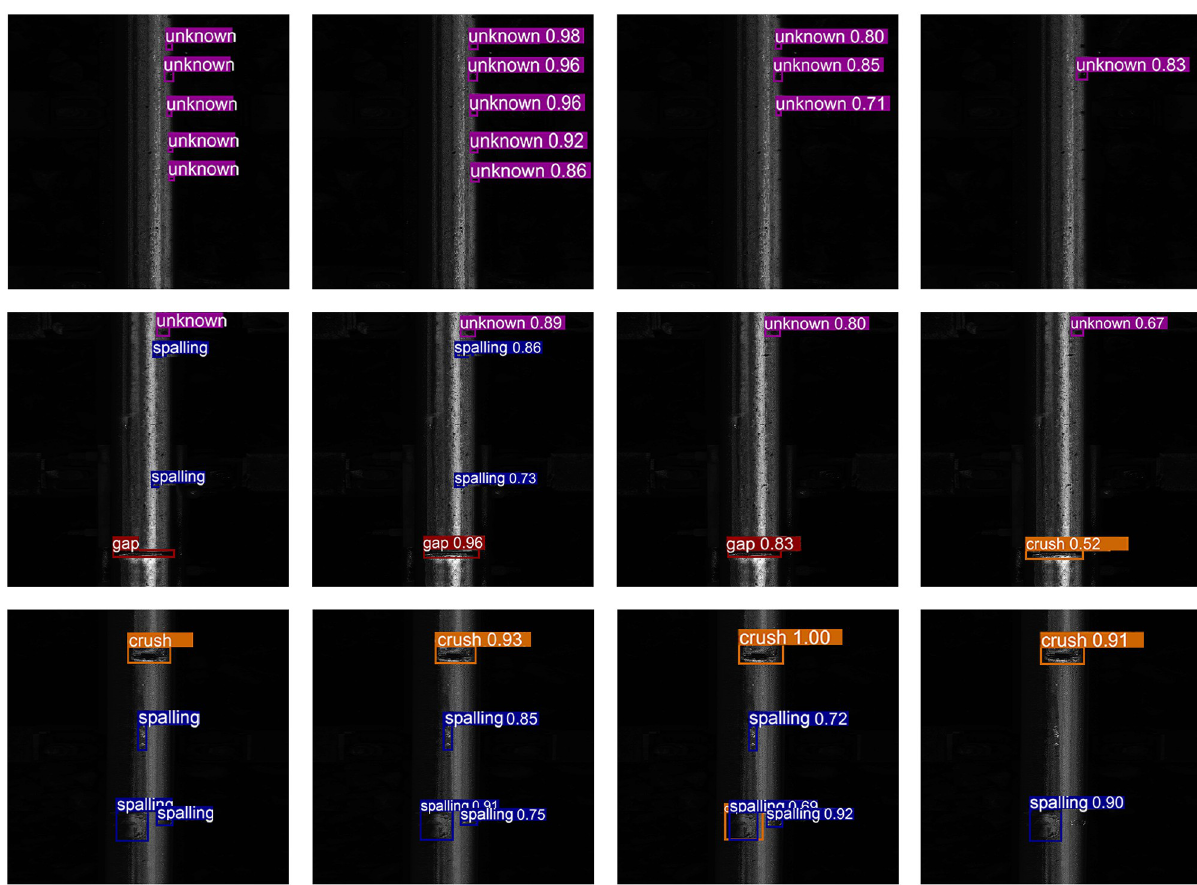
Fig 6. Detection result. From left to right are ground truth, MBDA, FasterRCNN, and YOLO.